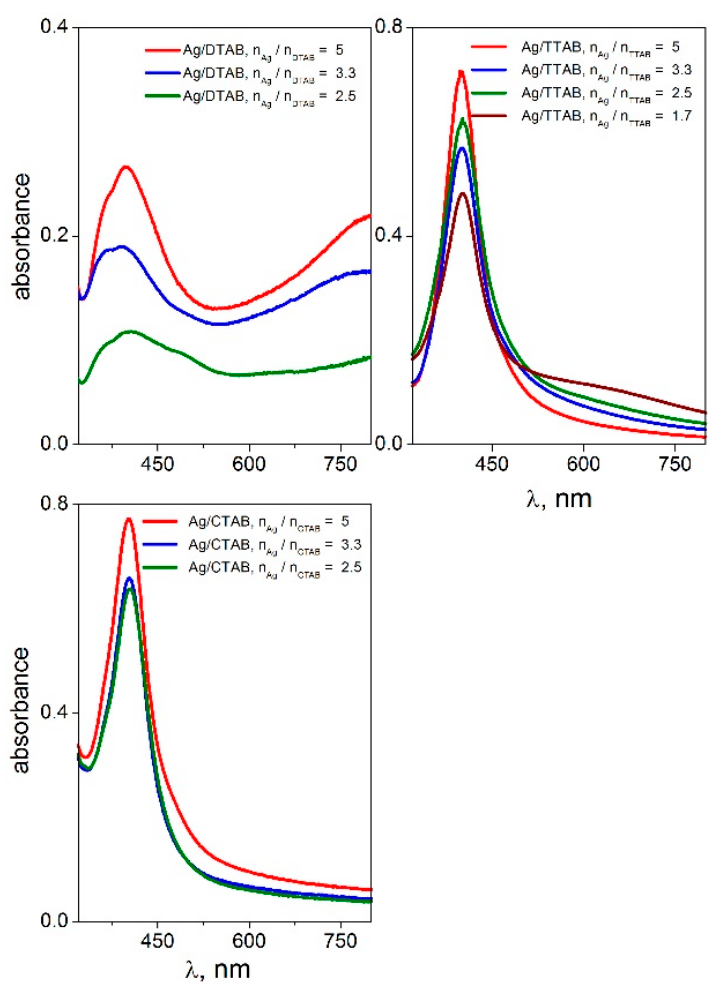
Figure 5. UV-VIS spectra of silver nanoparticles stabilized with single-chain surfactants DTAB, TTAB and CTAB at different molar ratio values n Ag /n surf .